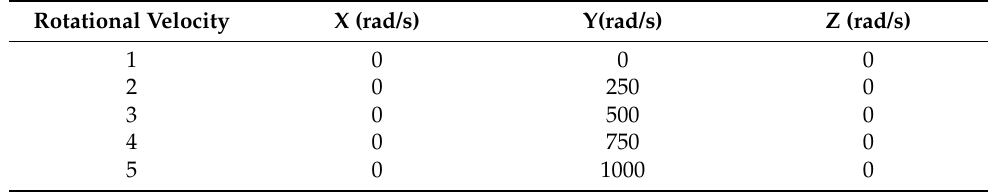
Table 5. Shafting rotational velocity for Campbell diagram.